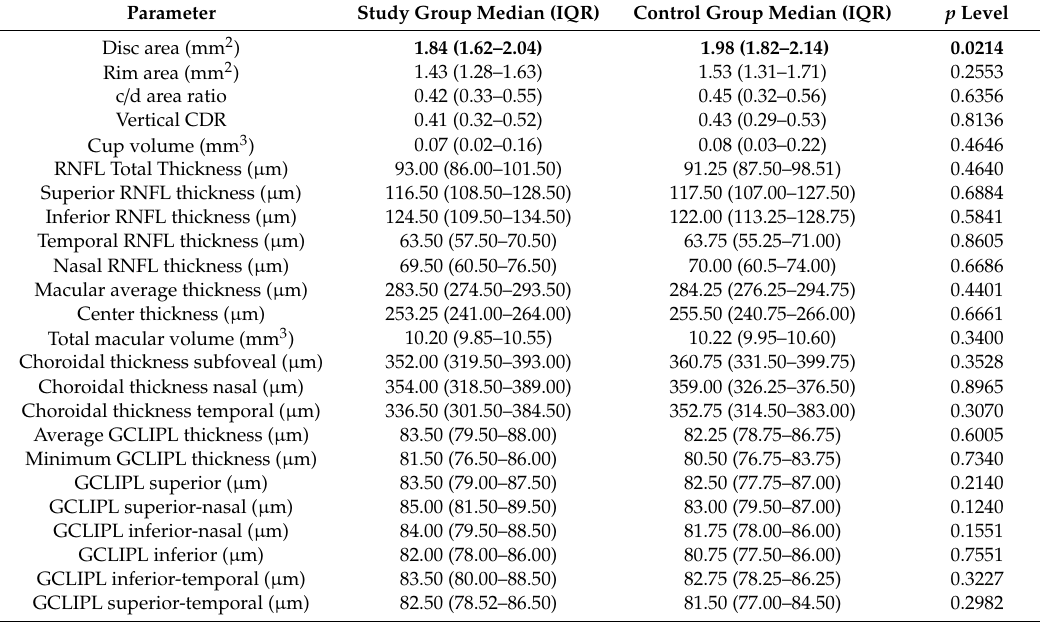
Table 2. Comparison of the parameters of ONH, thickness of RNFL and its quadrants, average retinal thickness, central retinal thickness, total retinal volume, CT and GCIPL thickness, assessed using high-definition optical coherence tomography HD-OCT of the study group of patients with T1D and control